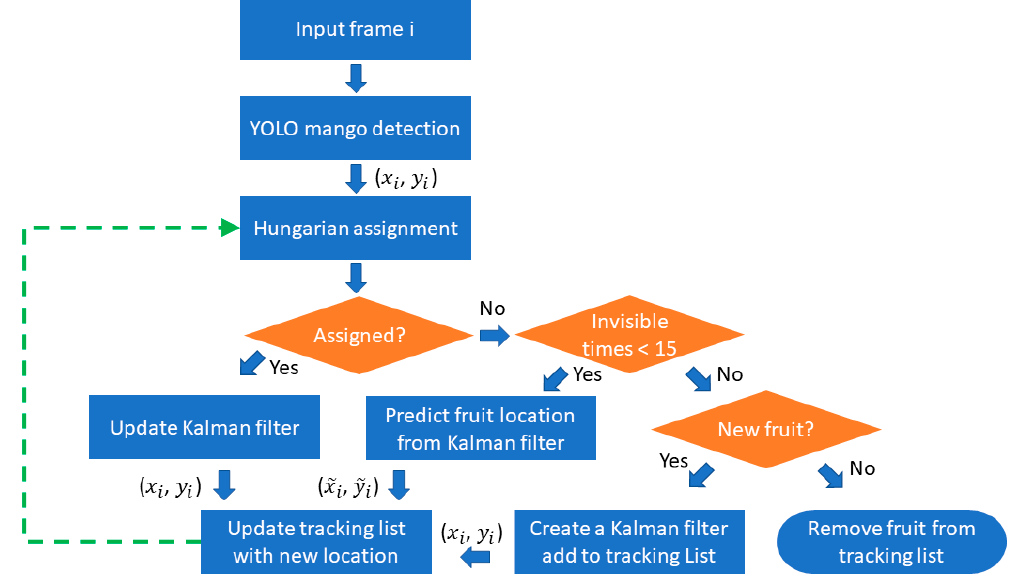
Figure 5. Workflow of the proposed method.